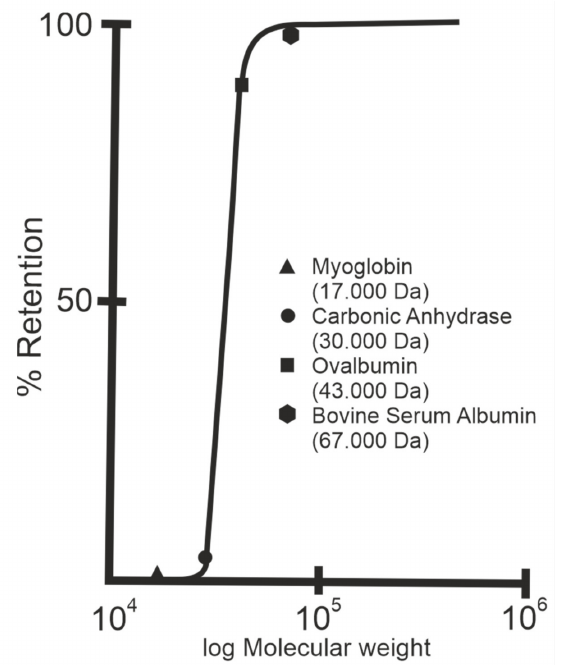
Figure 4. Rejection curve of S-layer ultrafiltration membranes. The isoporous S-layer fragments attached to a supporting microfiltration membrane form the active ultrafiltration layer responsible for the sieving properties. Note the steep increase between molecular weights 30.000 and 45.000 Da for S-layer fragments of Geobacillus stearothermophilus . (Adapted from [8]. Copyright © 1986 with permission from